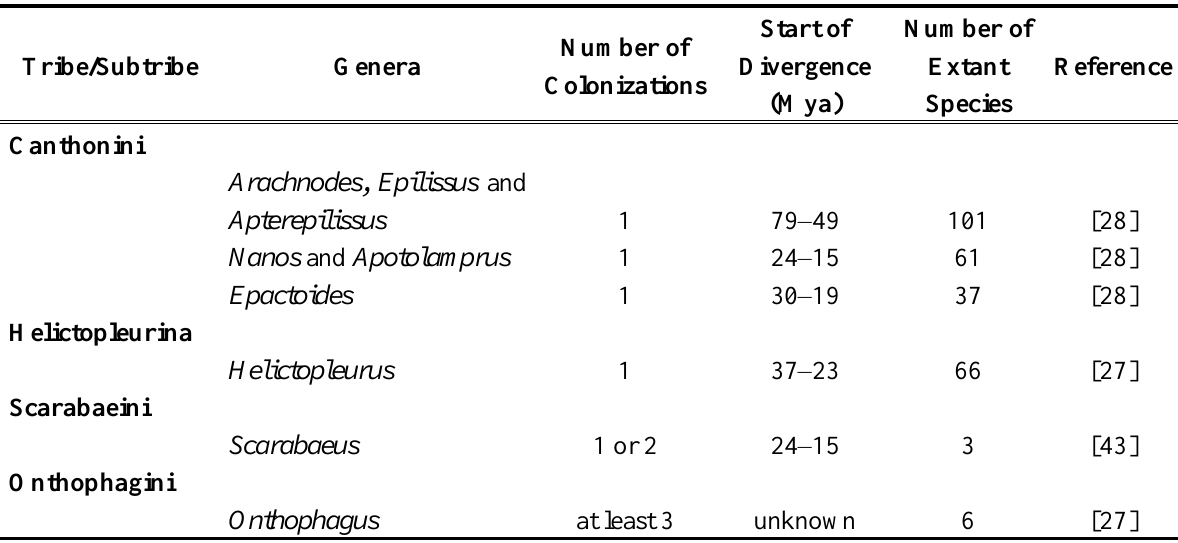
Table 1. Eight independent colonizations of Madagascar by Scarabaeinae dung beetles, with times of subsequent radiations and the number of extant